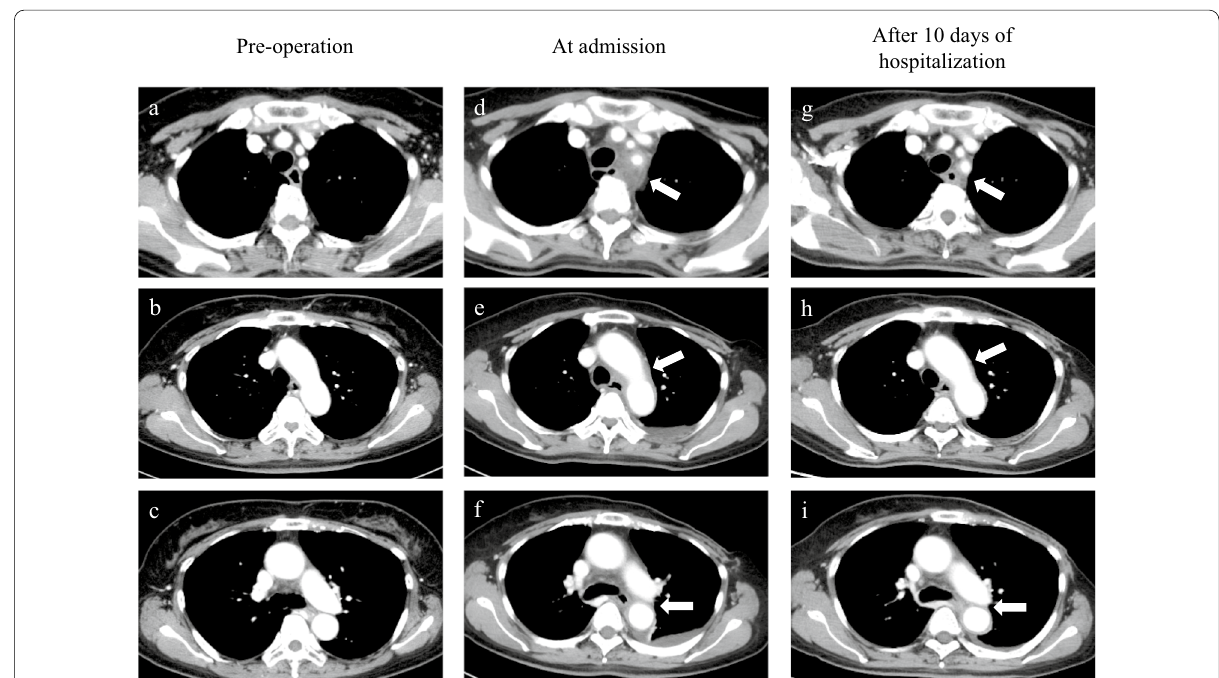
Fig. 1 Pre‑operation computed tomography (CT) revealed no abnormalities around the aorta ( a – c ). CT scanning at the time of admission ( d – f ) revealed thickening of the arterial wall of the thoracic and abdominal aorta and increased fat concentration in the surrounding area. A CT scan after 10 days of hospitalization revealed reduced arterial thickening and fat concentration relative to the CT at the time of admission ( g – i )